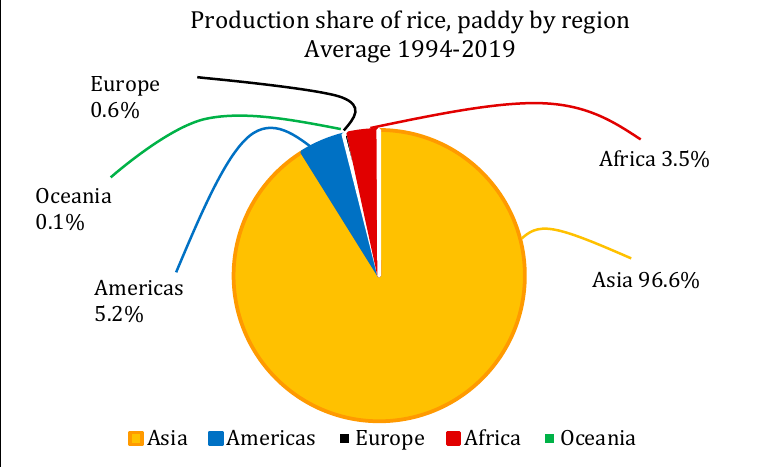
Figure 3. Rice production share in each continent (www.fao.org (accessed on 3 March 2022)).